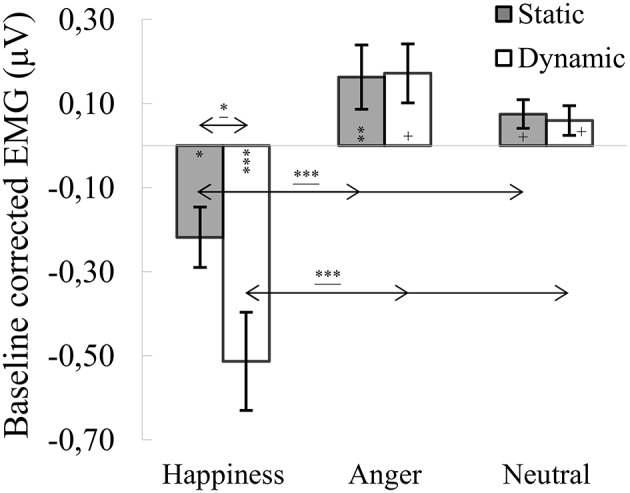
Mean (±SE) EMG activity changes and corresponding statistics for corrugator supercilii during presentation conditions. Asterisks with lines beneath indicate significant differences between conditions (simple effects) in EMG responses: *p < 0.05, ***p < 0.001. Separate asterisks indicate significant differences from baseline EMG responses: +p < 0.1, *p < 0.05, **p < 0.01, ***p < 0.001.